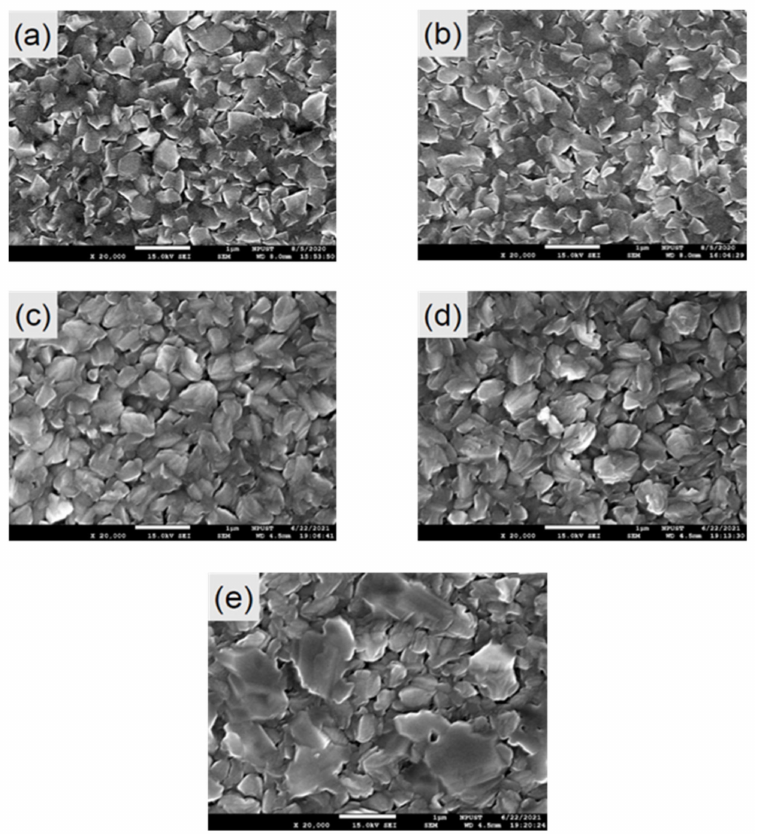
Figure 8. SEM micrographs showing sub-micrometer grain size of ZnO thin films annealed at different temperatures: ( a ) non-annealed, ( b ) 300 ◦ C, ( c ) 400 ◦ C, ( d ) 500 ◦ C and ( e ) 600 ◦ C.